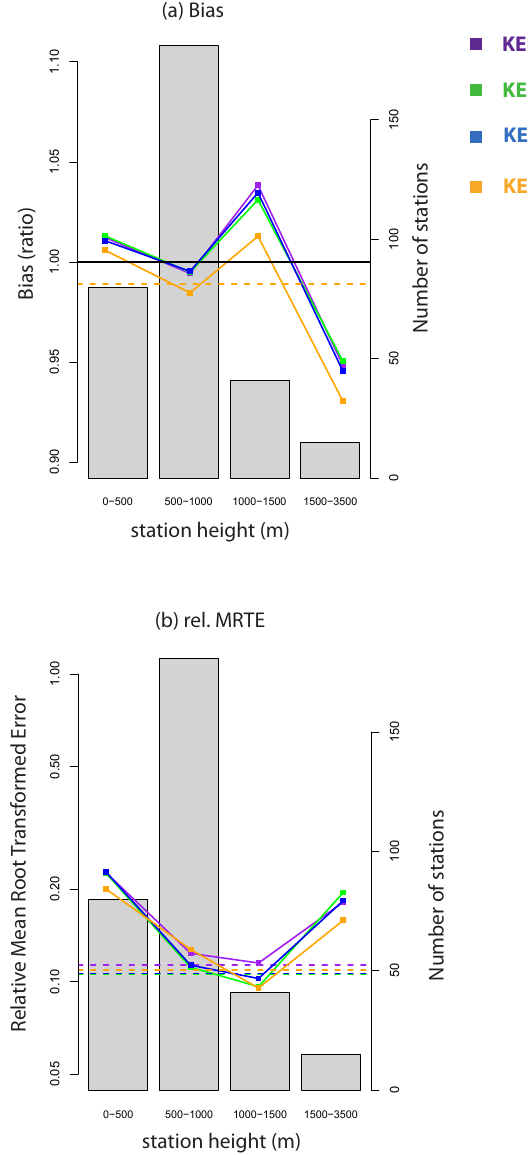
Figure 7. Error statistics for the interpolation of mean DJF pre- cipitation using interpolation models that utilize information from a circulation classification (see Table 1 for model acronyms). (a) Relative bias B (dimensionless, Eq. 3) and (b) relative mean root-transformed error E (dimensionless, Eq. (4), log scale) of a leave-one-out cross-validation. Results are shown for four elevation classes. Horizontal dashed lines represent the scores over all sta- tions. The vertical bars represent the number of stations per eleva- tion class (right axes).